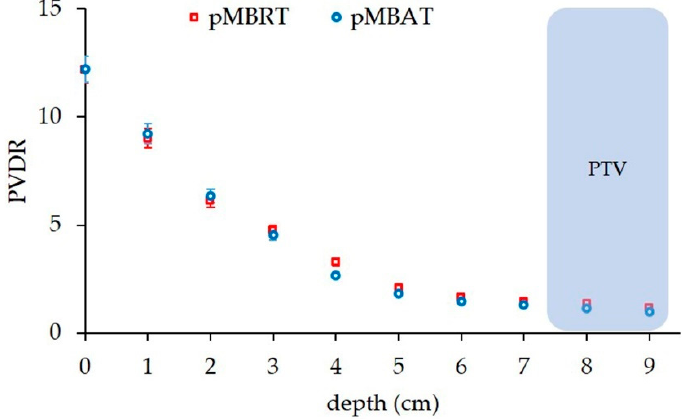
Figure 2. ( a ) Coronal, ( b ) sagittal views, and ( c ) sagittal view zoomed in of the pMBAT dose distributions.